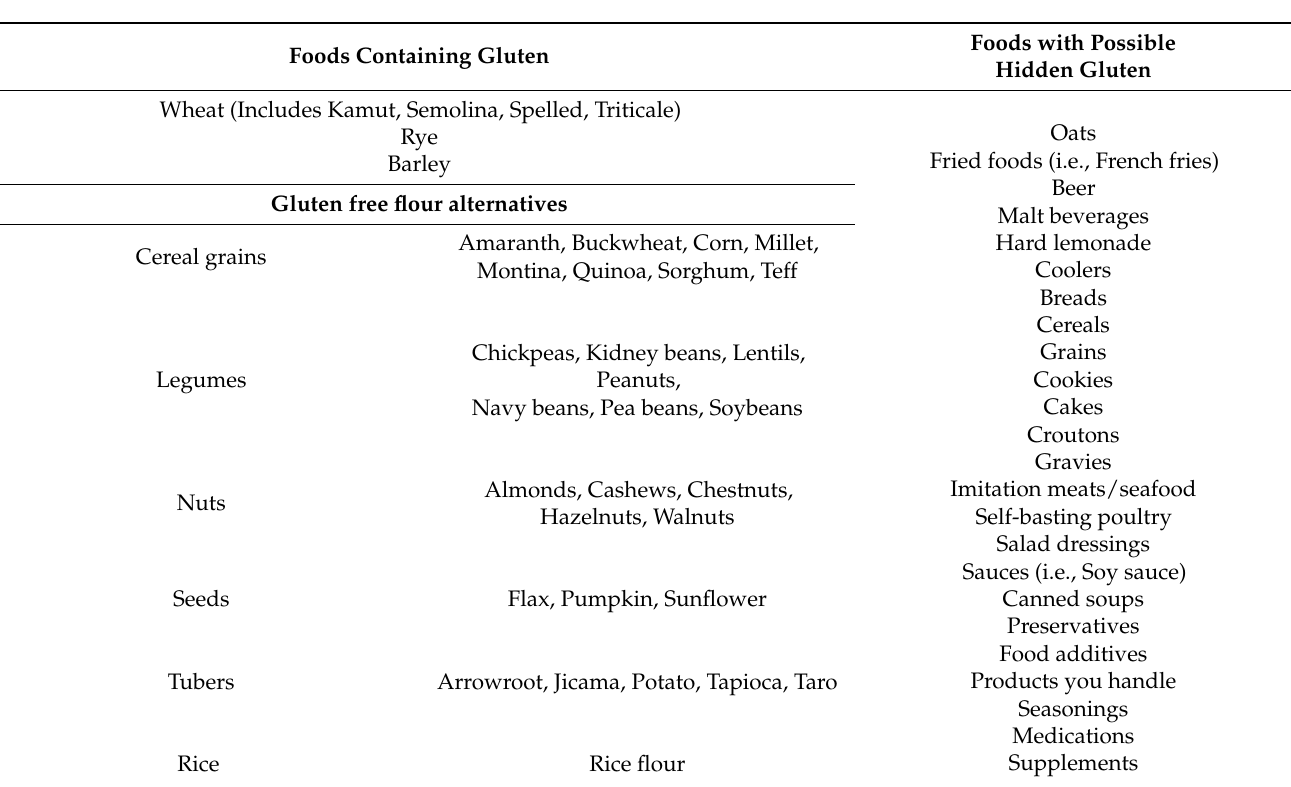
Table 4. Fundamentals of a gluten-free